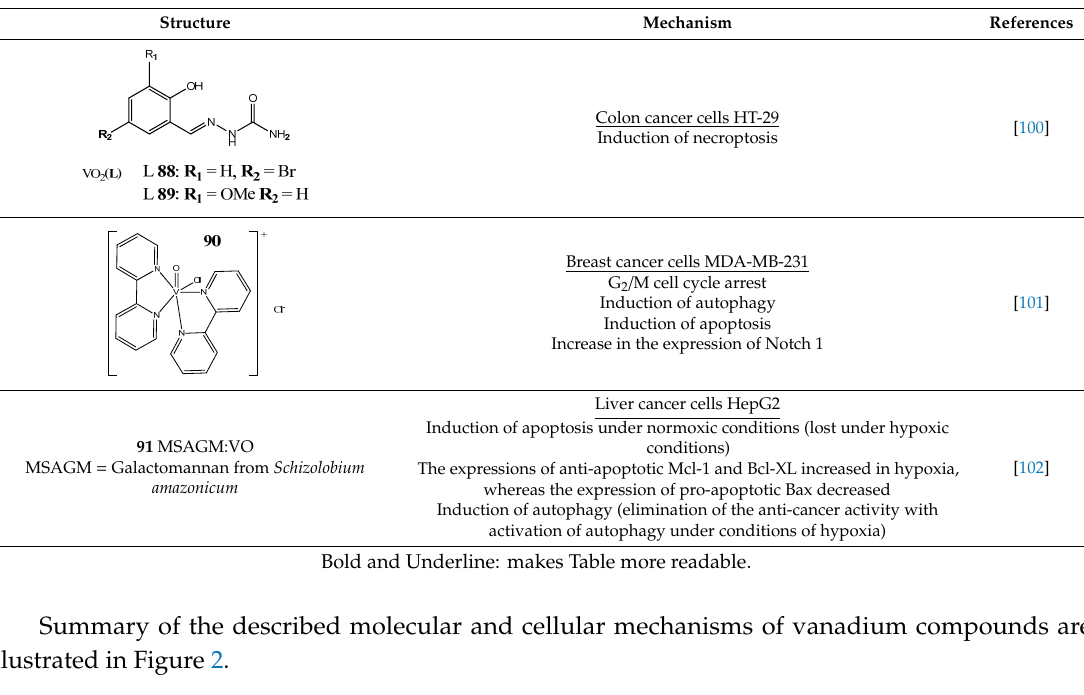
Bold and underline: makes table more readable.